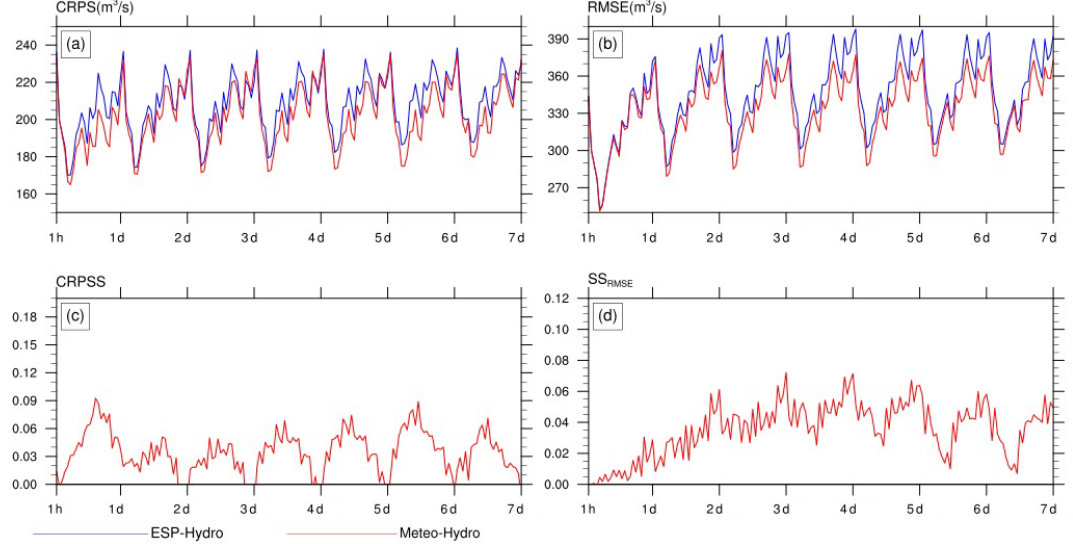
Figure 7. (a) The continuous ranked probability score (CRPS) and (b) root-mean-squared error (RMSE) for the daily streamflow ensemble forecasts at the Yantan hydrological gauge. Panels (c) and (d) show the skill score in terms of the CRPS and RMSE for Meteo-Hydro, where ESP-Hydro is used as the reference forecast.